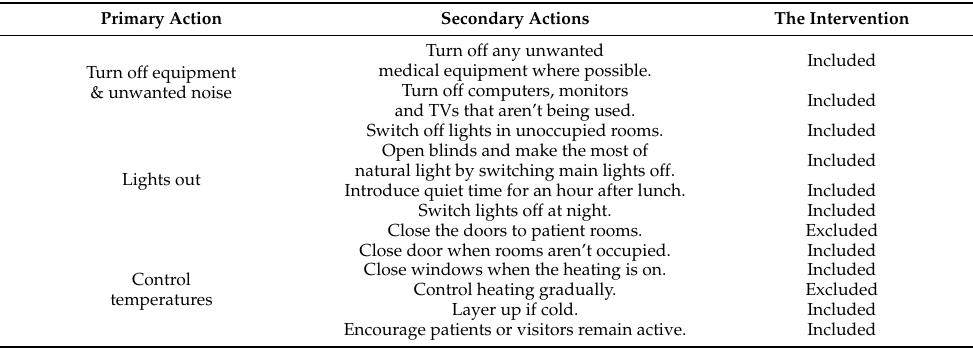
Table 1. Operation TLC staff actions adapted for use in the intervention wards during the behavior change study at the NHS community hospital participating in the study. Primary Action Secondary